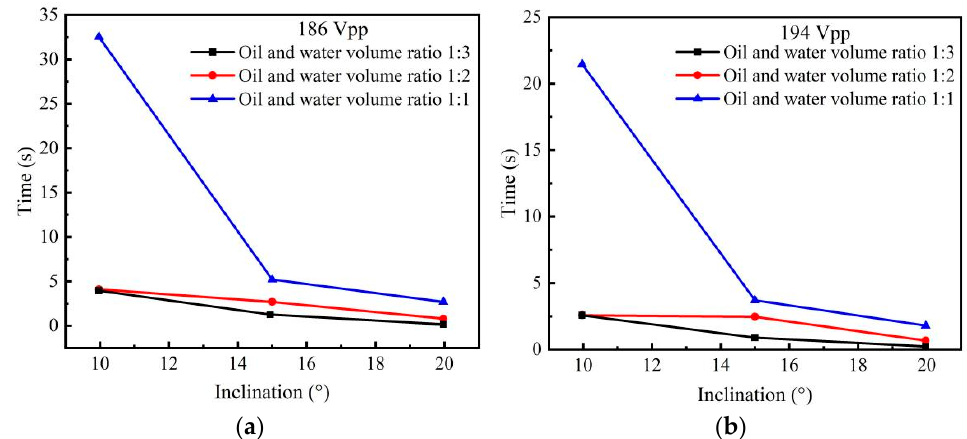
Figure 6. The effect of inclination angle on the oil/water mixture separation time. ( a ) When the input power is 186 VPP, the relationship between the oil/water mixed droplet separation time and inclination angle with the oil/water volume ratio from 1:1 to 1:3 on the mirror substrate. ( b ) When the input power is 194 VPP, the relationship between the oil/water mixed droplet separation time and inclination angle with the oil/water volume ratio from 1:1 to 1:3 on the mirror substrate. Reproduced from Ref. [96].